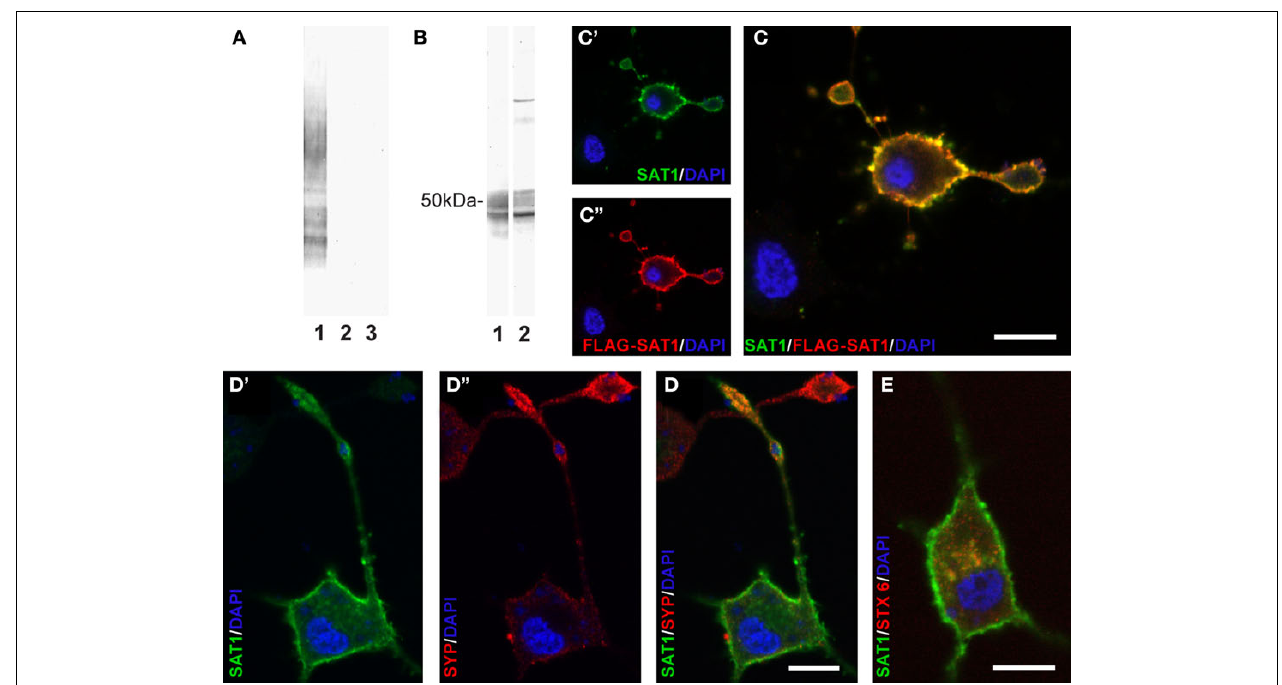
antibody against FLAG-epitope (C’’) . Superimposition of the images shows that both antibodies stain the same subset of PC12 cells. Note that the staining occurs in the cell bodies as well as in their processes. Note also that a cell not immunostained by anti-FLAG is not immunostained for SAT1 either. (D) SAT1 (green; D’ ) is targeted to the processes also labeled for synaptophysin (red; D’’ ), a vesicular protein, demarcating axonal endings of differentiated SAT1 transfected PC12 cells. Note that an adjacent putative untransfeced cell stains strongly for synaptophysin, but eludes immunostaining by SAT1 antibody. (E) Double labeling of differentiated SAT1 transfected PC12 for SAT1 and syntaxin-6 (stx6), a marker of the trans -Golgi network, shows pronounced colocalization in the perinuclear region. All sections have been counterstained by DAPI (blue). Scale bar: 20